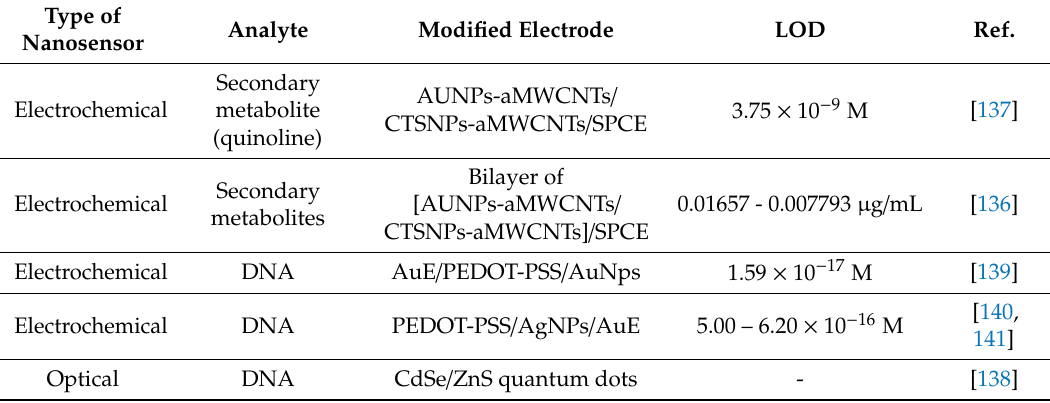
Table 5. Nanosensors used in the detection of basal stem rot / Ganoderma disease in oil palms. Type